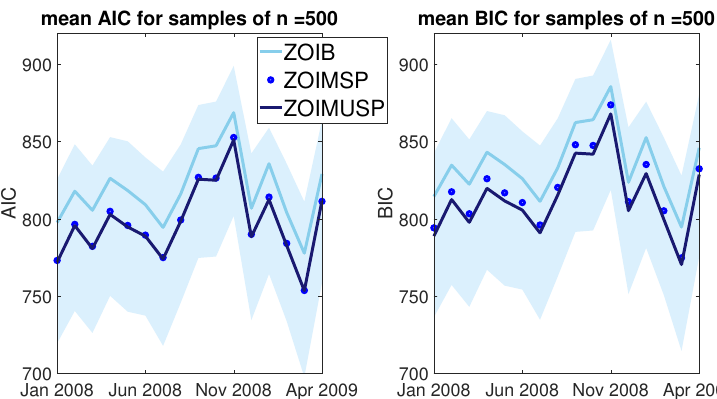
Figure 14. Bootstrap estimated mean of the AIC and BIC for the ZOIB, ZOIMSP, and ZOIMUSP models for a sample size of n = 500. The shaded area represents a 90% confidence interval for the mean of the ZOIMUSP model.